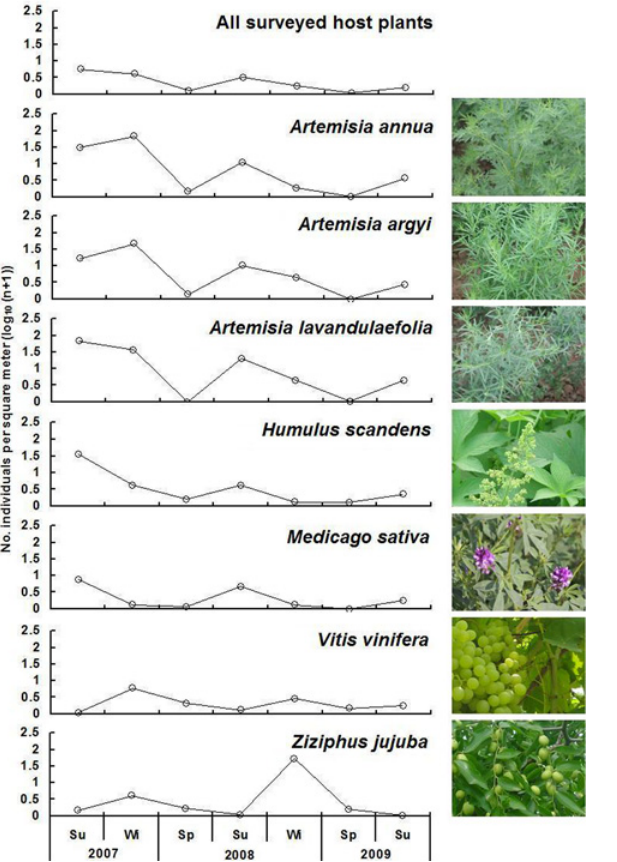
Fig 3. Seasonal population densities of Apolygus lucorum on the 7 principal host plants during 2007 – 2009 at Langfang (Hebei Province, Northern China). A total of 21 species were used as host plants throughout spring, summer and winter. Among 21 year-round hosts, only 7 species were found with relatively high A . lucorum population [32,33].